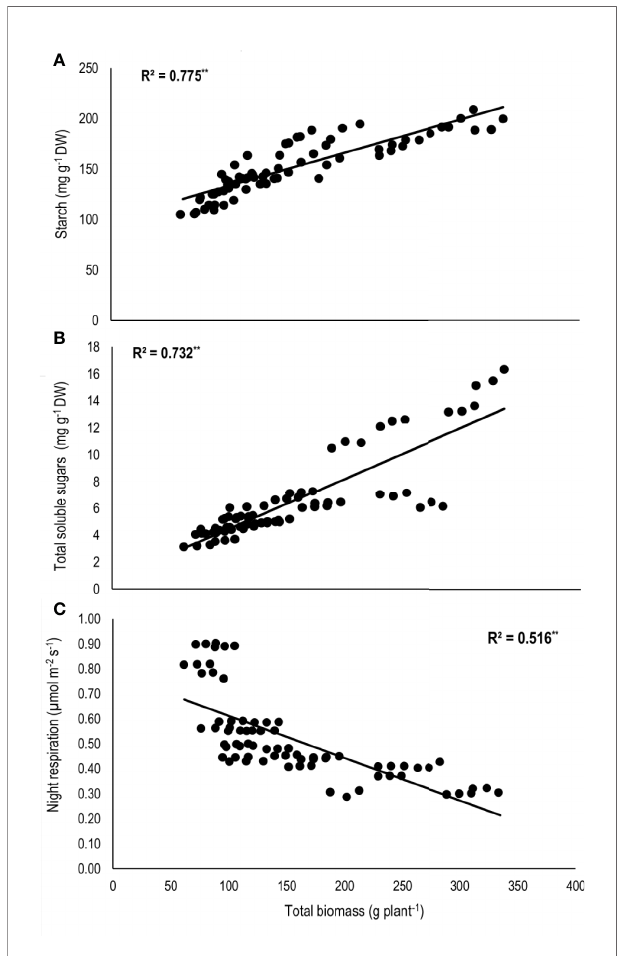
FIGURE 5 | Relationship of total biomass (TB) with (A) starch, (B) total soluble sugars (TSS), and (C) night respiration of two sorghum hybrids (DK 53 and DK 28E) exposed to two mean temperatures (27 and 35°C) [27°C (optimum mean daytime and nighttime temperature; ODNT) and 35°C (high mean daytime and nighttime temperature; HDNT)] with three diurnal temperature amplitudes (2, 10, and 18°C). Coef fi cient of determination (R 2 ) followed by ** signi fi cant at P < 0.01. Dry weight (DW).